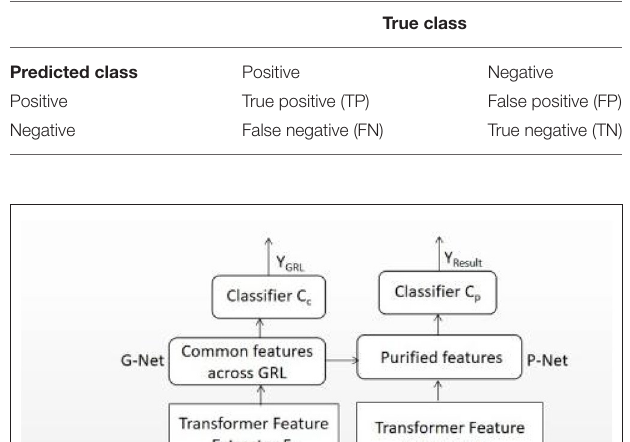
TABLE 1 | Relationship between predicted and true classes.